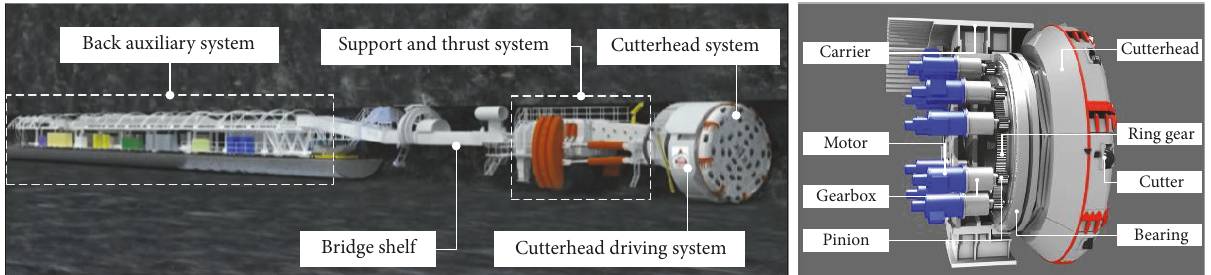
Figure 1: Structure diagram of the TBM and its cutterhead driving system